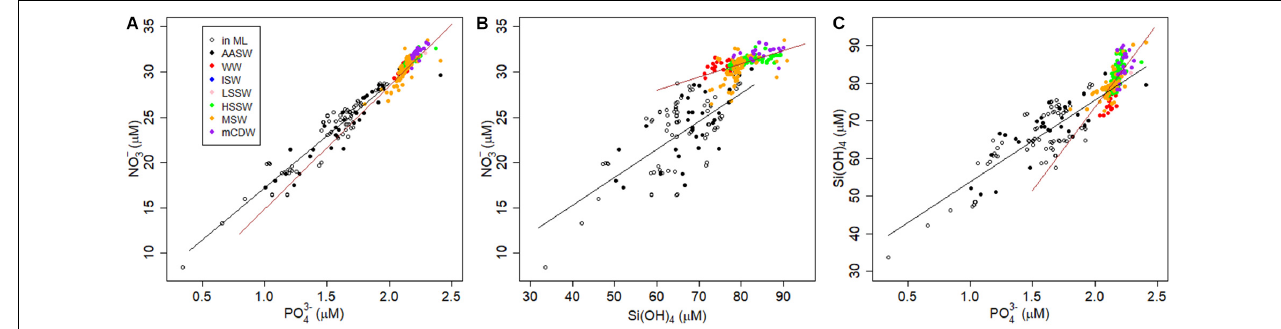
FIGURE 7 | Macro-nutrient property-property plots in µ M of all stations. (A) NO 3 − vs. PO 43 − , (B) NO 3 − vs. Si(OH) 4 , (C) Si(OH) 4 vs. PO 43 − . Colors indicate water mass, open symbols are samples in AASW from within the ML, filled symbols in AASW are from below the MLD. Lines depict the linear regressions inside (black lines) and outside AASW (brown lines) ( Supplementary Table S1